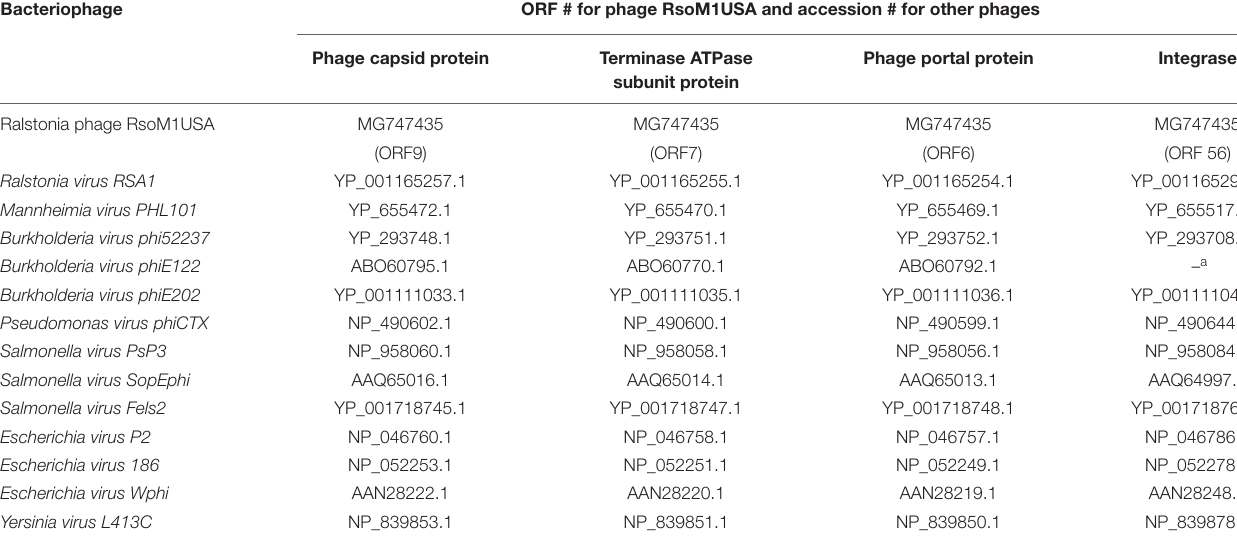
TABLE 2 | List of proteins and their ORFs or accession numbers of bacteriophages used for phylogenetic analysis in this study.